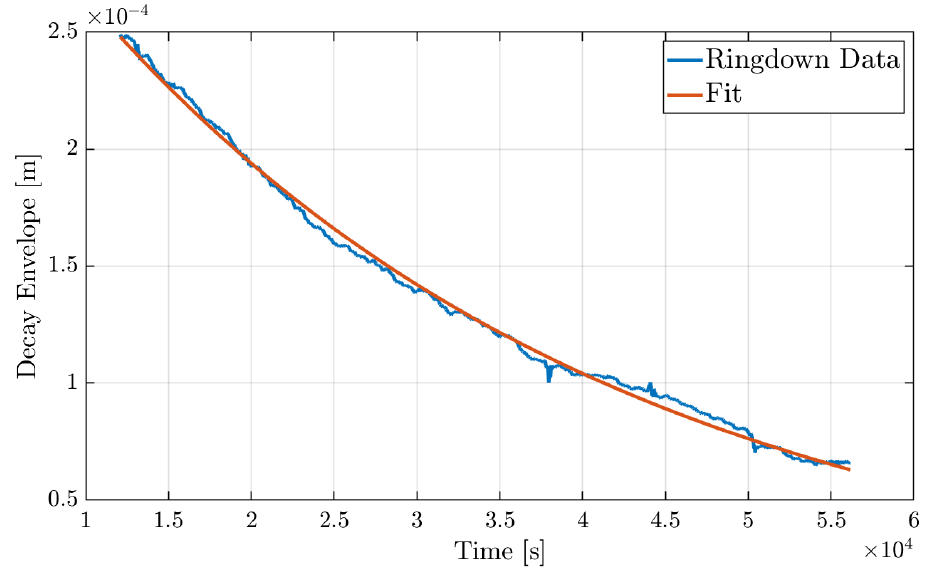
Figure 3. Decay envelope of our ringdown measurement fitted to an exponential. The resonant frequency was removed with a low-pass filter, allowing us to calculate a Q -factor of 4.76 ( 3 ) × 10 5